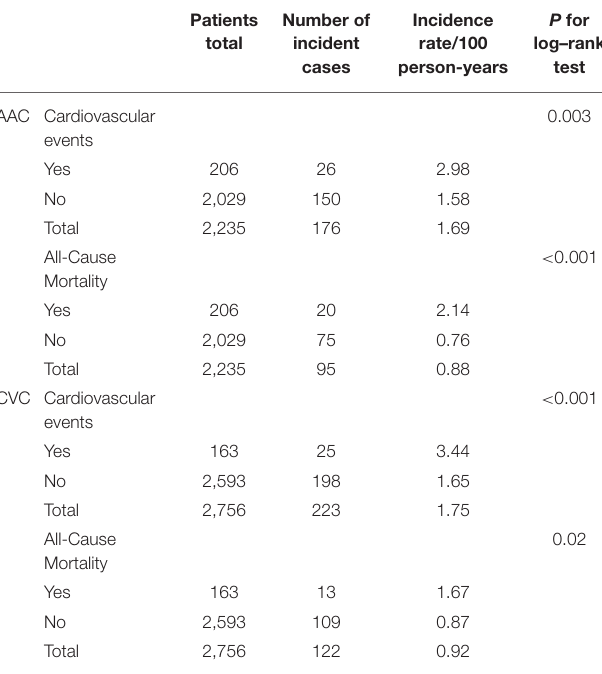
TABLE 2 | (A) Multivariable logistic regression analysis for AAC in patients with CKD Stages 1–4. (B) Multivariable logistic regression analysis for CVC in patients with CKD Stages 1–4.